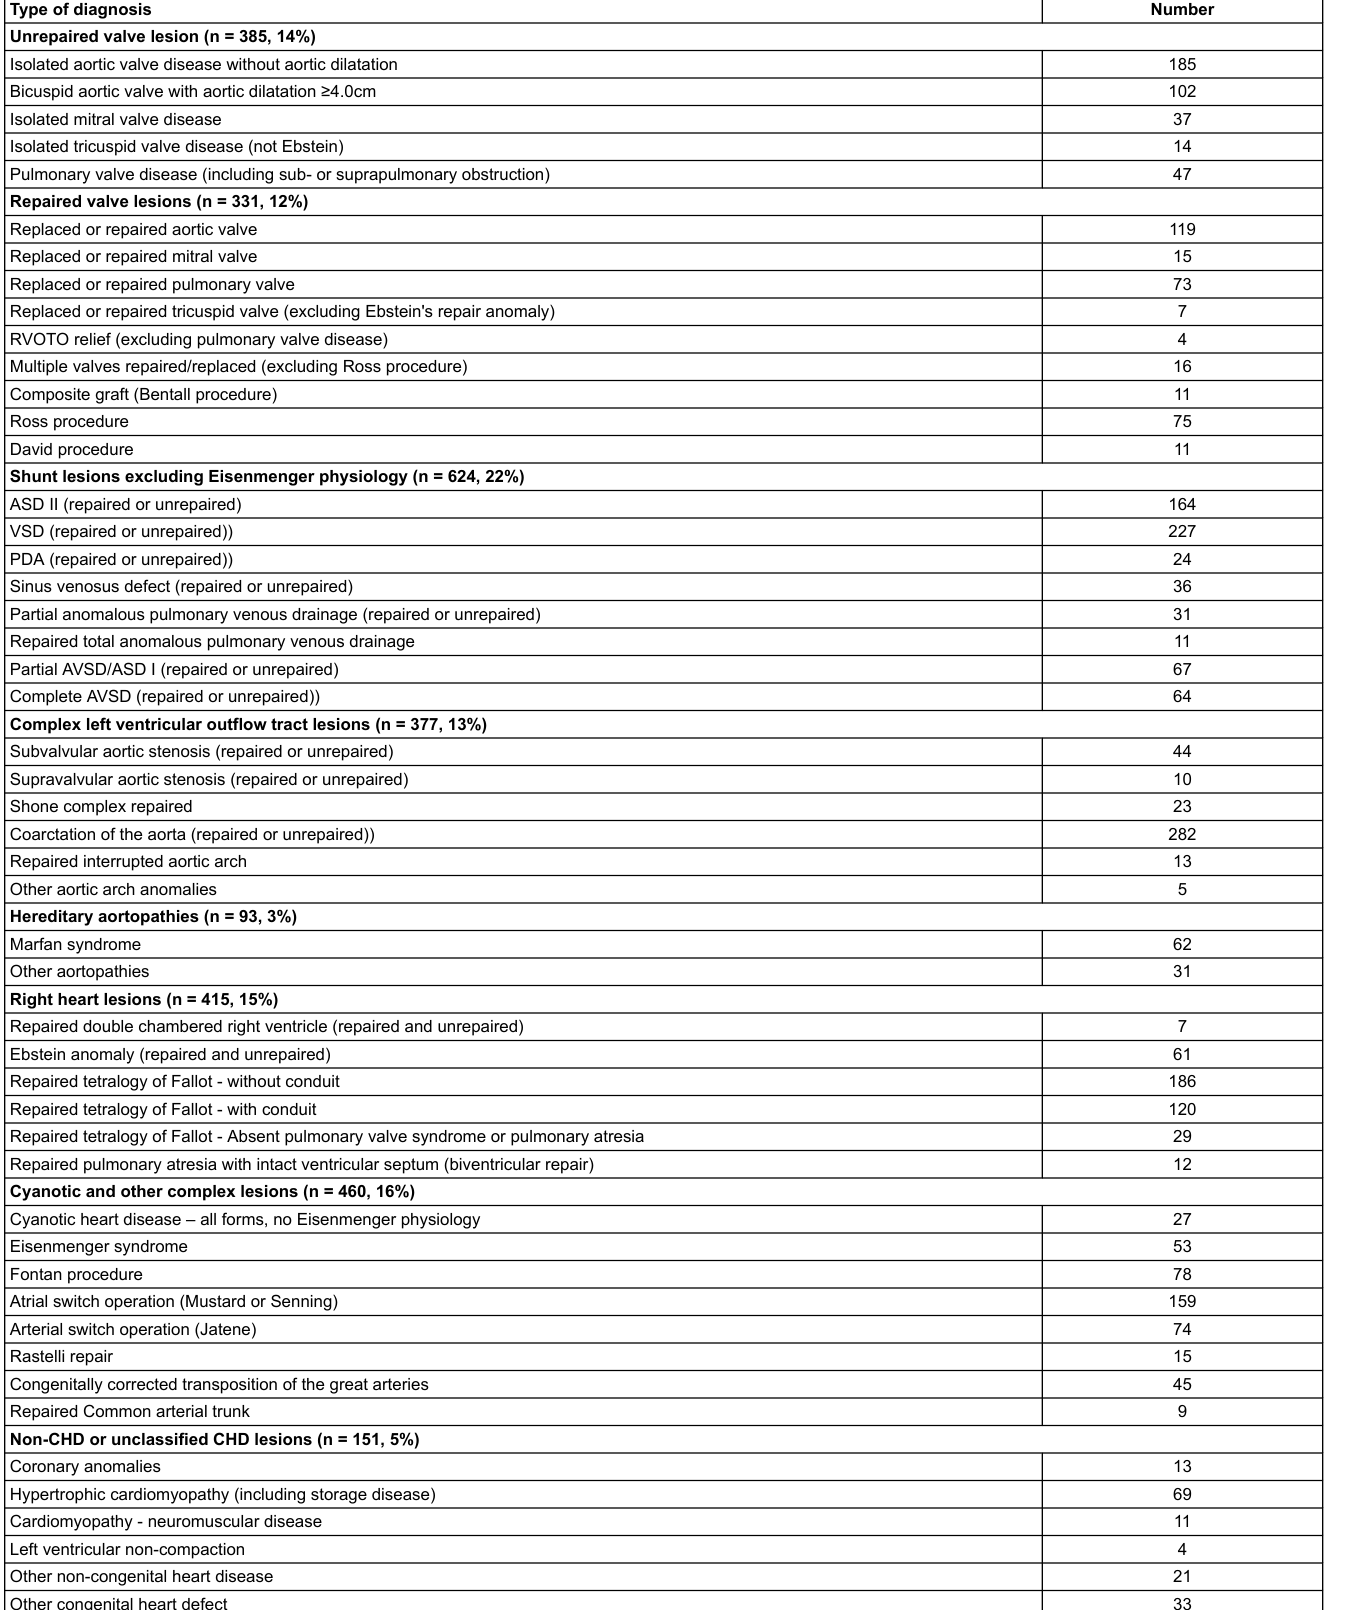
Table 2: Number of patients for each of the working diagnoses. Type of